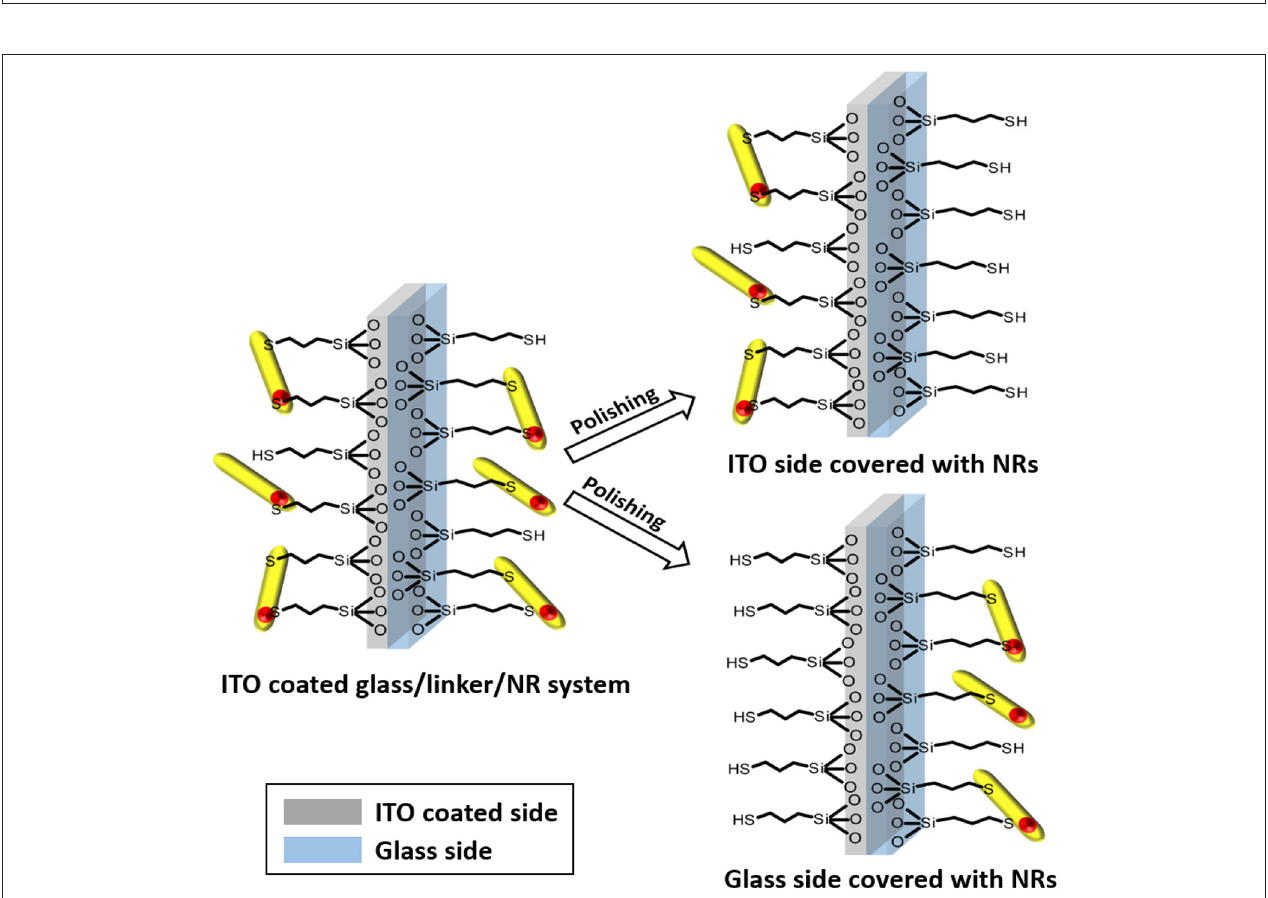
Frontiers in Chemistry | www.frontiersin.org